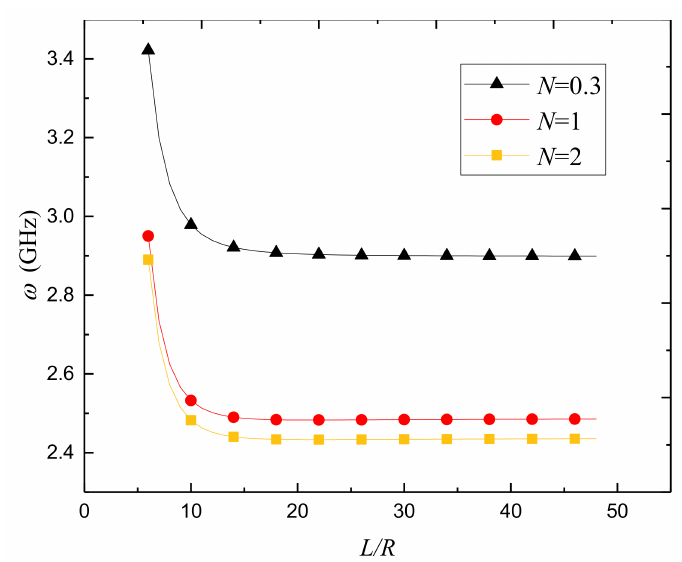
Figure 3. Variation of natural frequency ω (GHz) against length-to-radius ratio for different power-law indexes N of FGPM-I nanoshell ( n = 3).